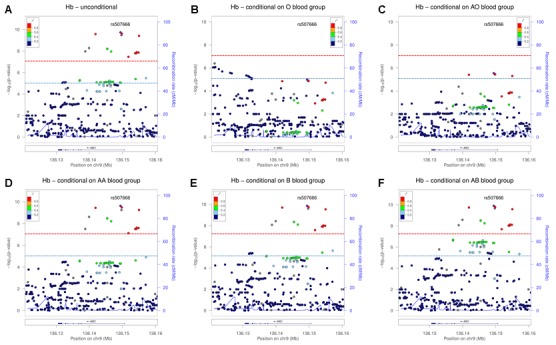
Meta-analysis association results for hemoglobin in unconditional and conditional analyses in the ABO locus.Regional plots show (A) unconditional analysis and analysis conditional on (B) O, (C) AO, (D) AA, (E) B and (F) AB blood group haplotype. The most significant SNP in the unconditional analysis, rs507666, is highlighted throughout to facilitate comparison of results. The color coding of the LD between the SNPs ranges from dark blue for r2 = 0–0.2 to red for r2 = 0.8–1, and is grey where LD information was not available. Blue line represents suggestive and red line significant threshold.